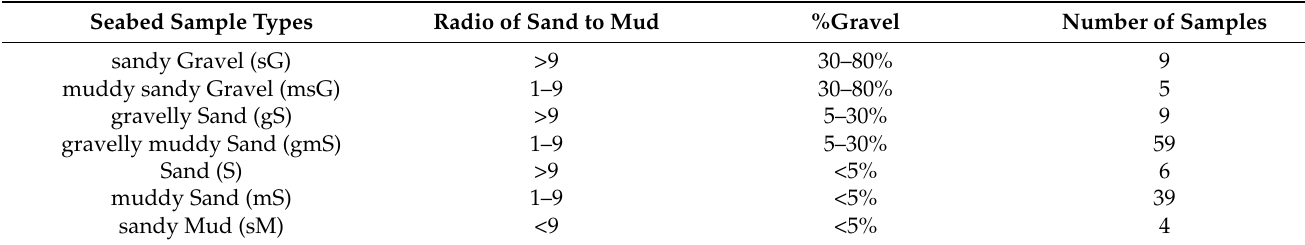
Table 1. The modified Folk classification for classifying the sediment samples.